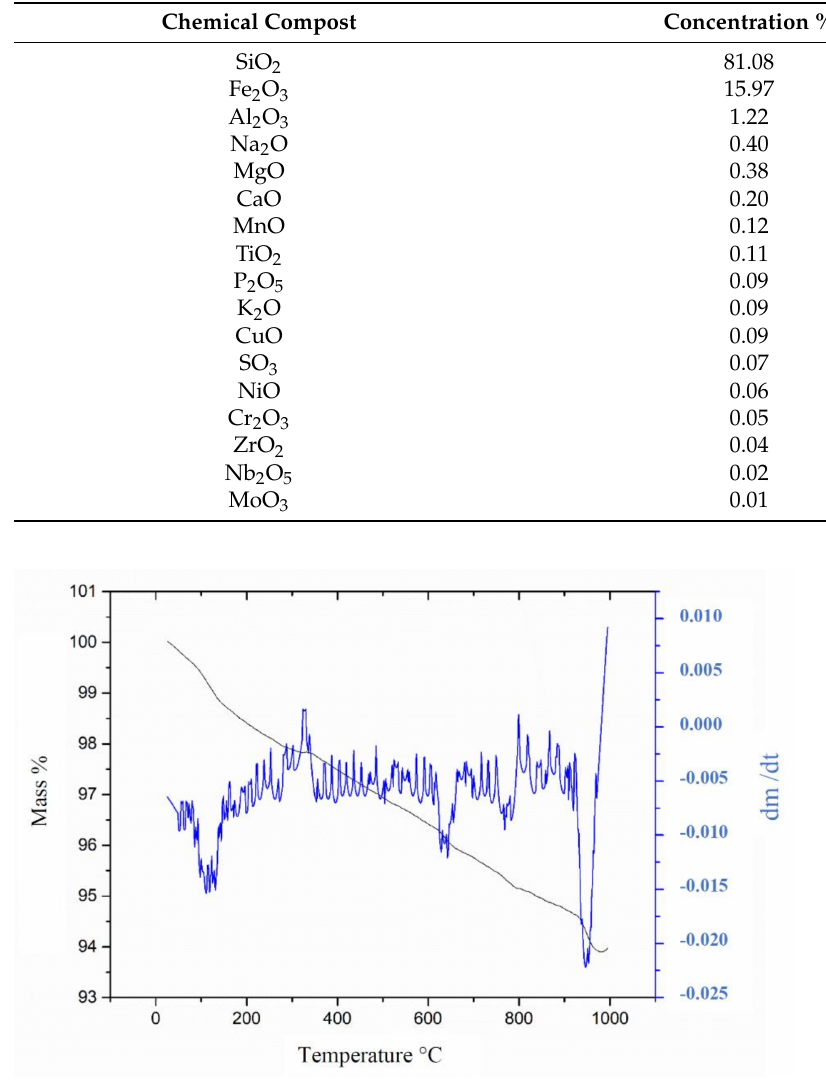
Table 6. WFES chemical composition.